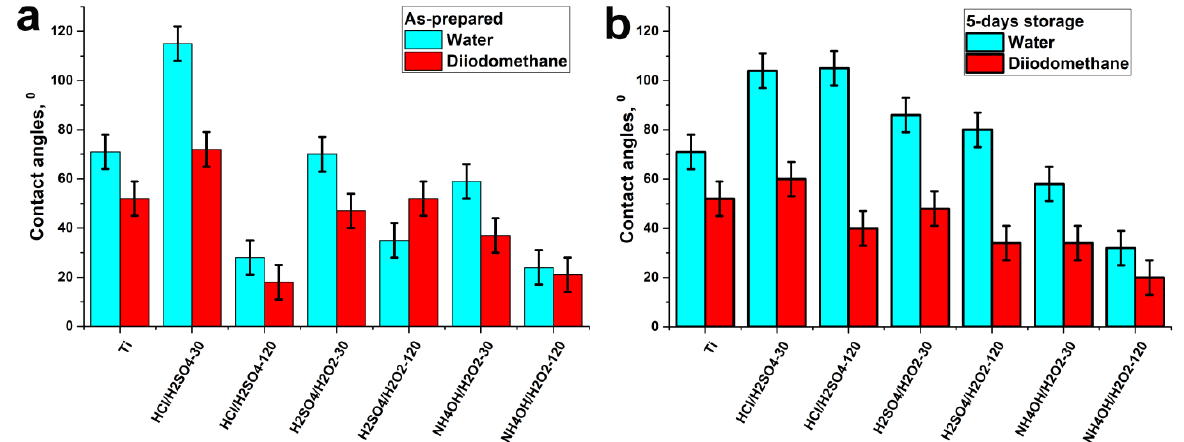
Figure 5. Results of water and diiodomethane contact angle measurements of as-prepared ( a ) and aged in the air ( b ) samples.